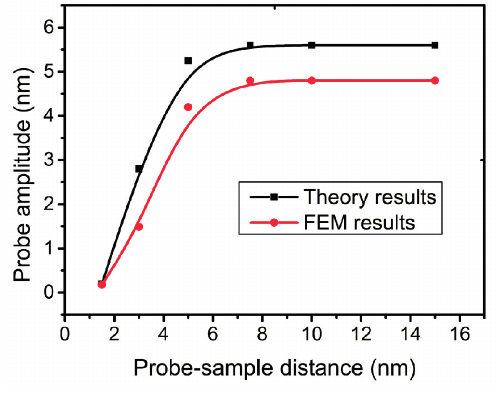
Figure 19. Approach curves calculated by FEM and beam